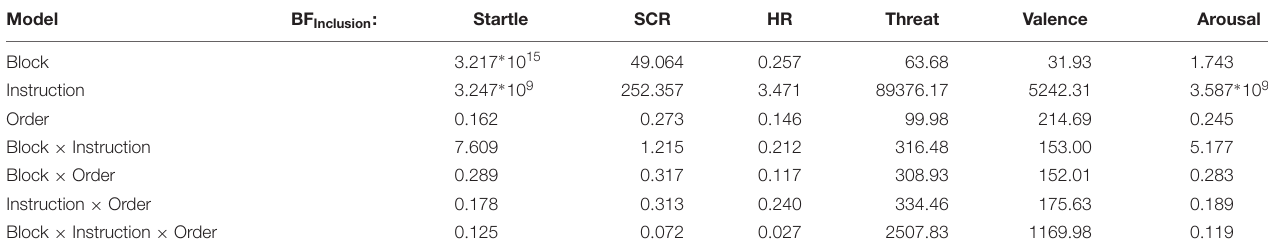
TABLE 1 | Bayes factors (BF incl ) of the selected models compared to all models without this factor for the different dependent measures.